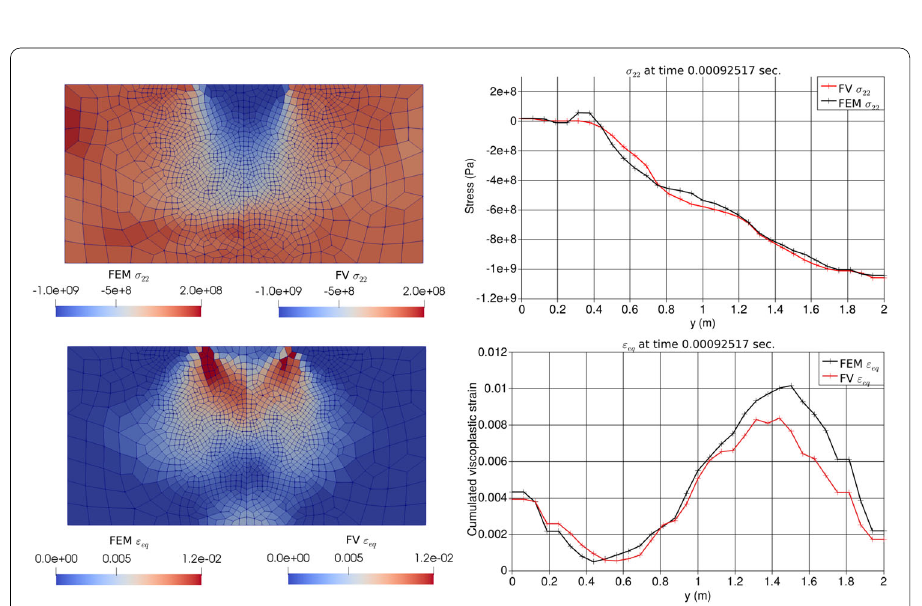
Fig. 13 Normal stress σ 22 and cumulated viscoplastic strains ε eq ≡ p at time 9 . 25 × 10 − 4 s, computed with finite elements (left-half domain) and finite volumes (right-half domain). Superposed plots are made along the symmetry line